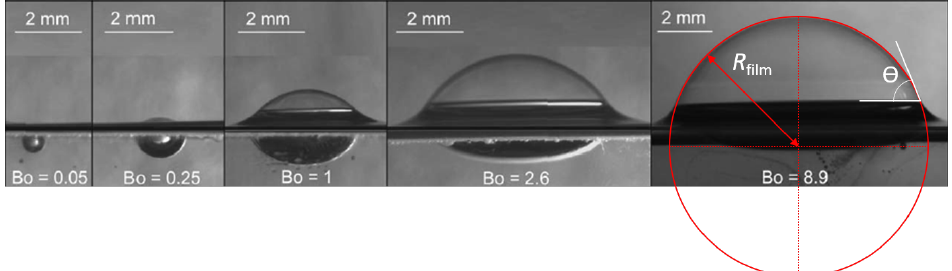
Figure 2. Adapted with authorization from Nguyen et al. [31]. Pictures of surface bubbles of varying Bond